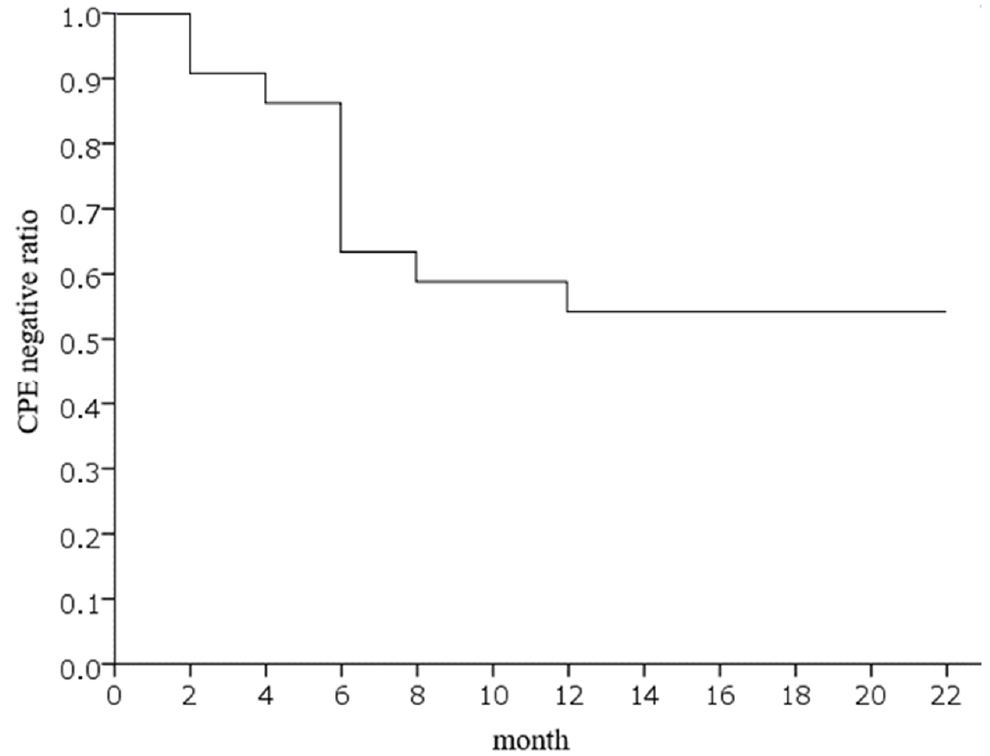
Figure 2. Kaplan–Meier curves for carbapenemase-producing Enterobacterales (CPE) negativity in 22 sink outlets after steam disinfection. Table 2. Duration required by the bacterial species to recontaminate the hospital sink outlets.